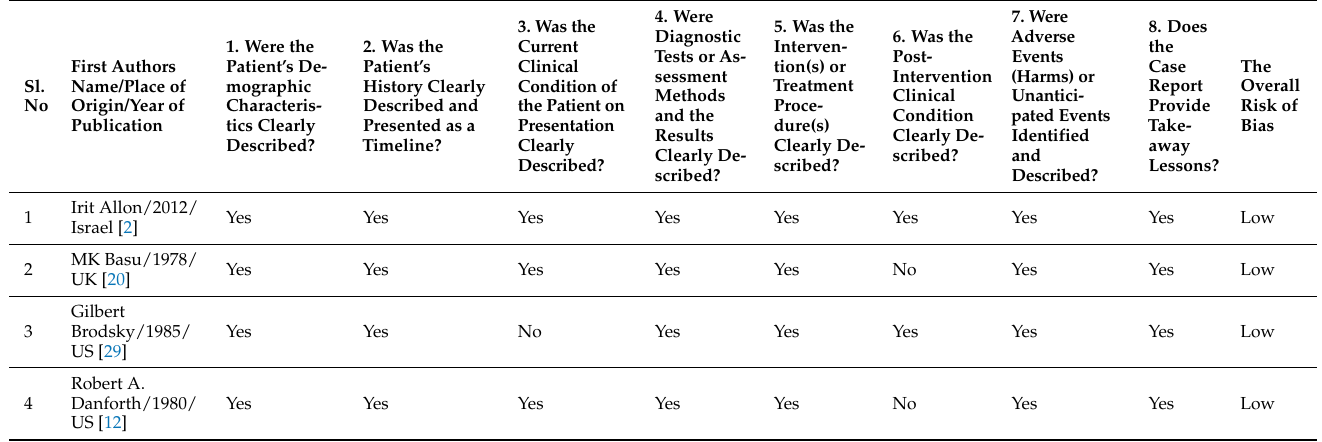
Table 2. Risk of bias evaluation of the included studies- The Joanna Briggs institute critical appraisal checklist for case